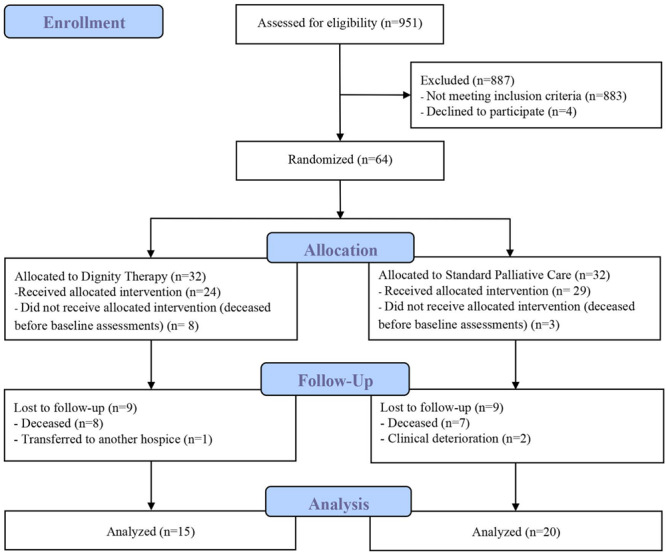
Flowchart diagram.